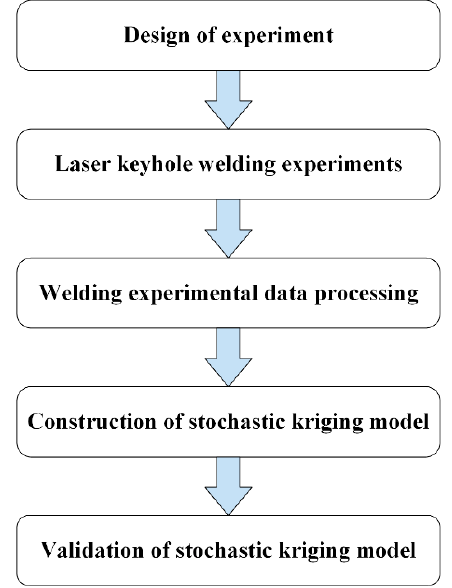
Figure 3. General framework of the proposed approach.